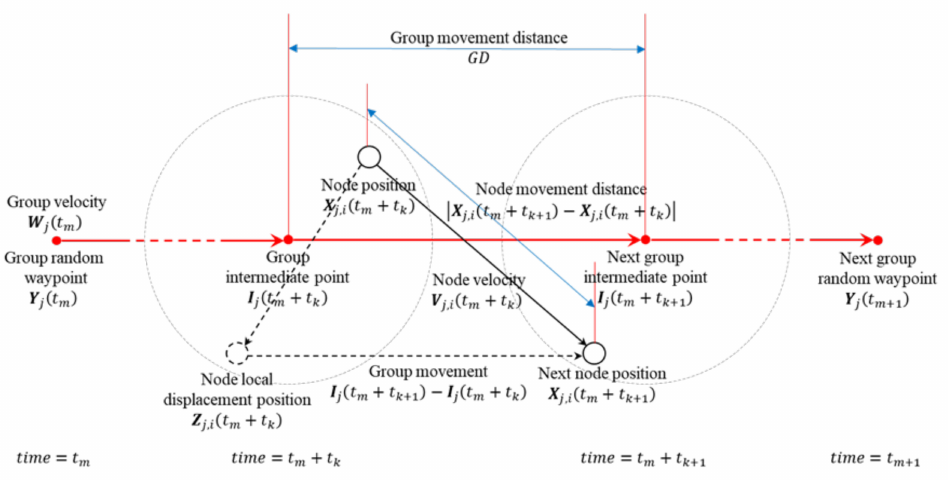
Figure 2. A movement model of nodes in a